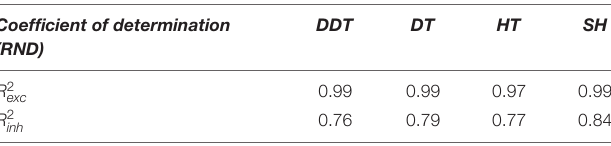
TABLE 1 | Coefficients of determination of the excitatory ( R 2 exc ) and inhibitory ) gaussian models used to fit RND networks degree distribution. ( R 2 inh